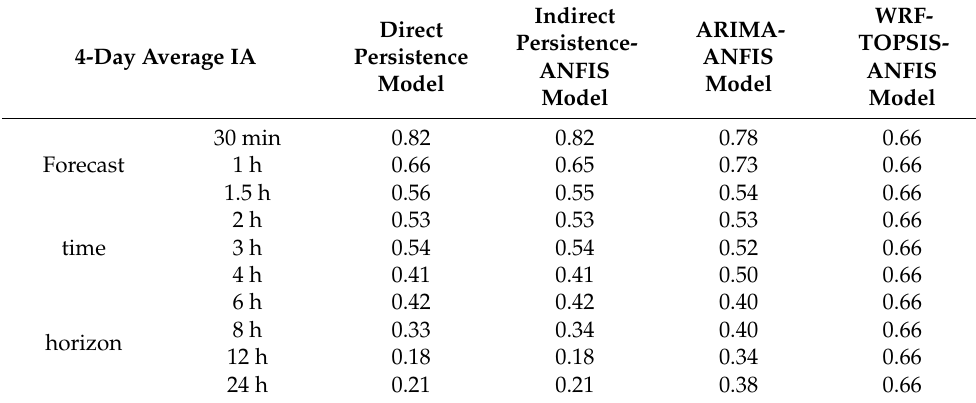
Table 16. Four-day average index of agreement for the wind power forecasting using the direct persistence, indirect persistence-ANFIS, ARIMA-ANFIS, and WRF-TOPSIS-ANFIS models applied to the 4-day test dataset.